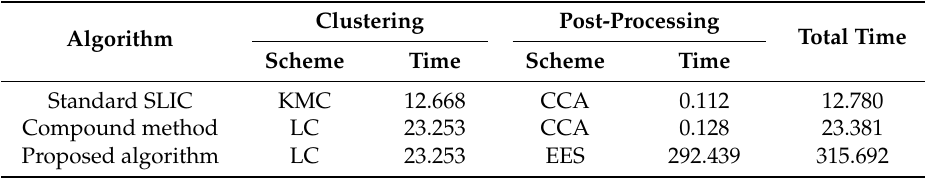
Table 3. Time (in second) of three superpixel algorithms with Synthetic Aperture Radar (EMISAR) images.